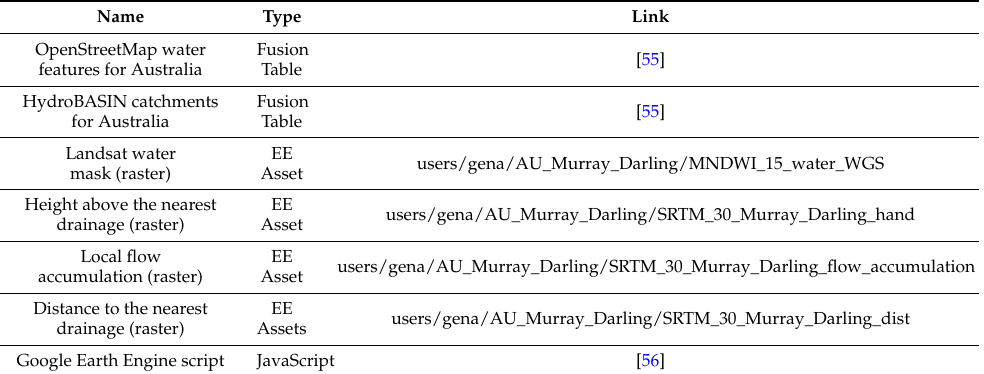
Table A1. List of vector and raster datasets available online.